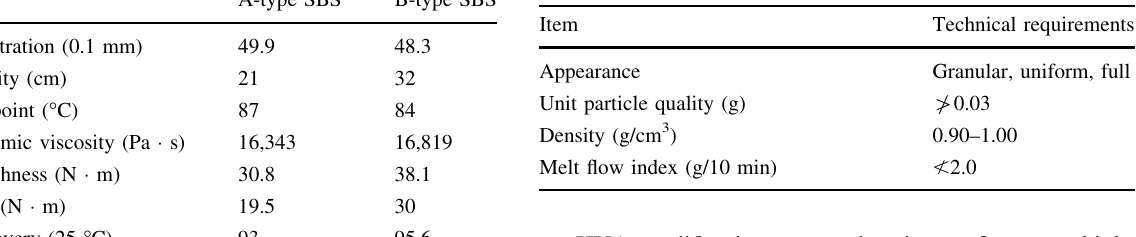
Table 1 Properties of the various types of SBS asphalt binders